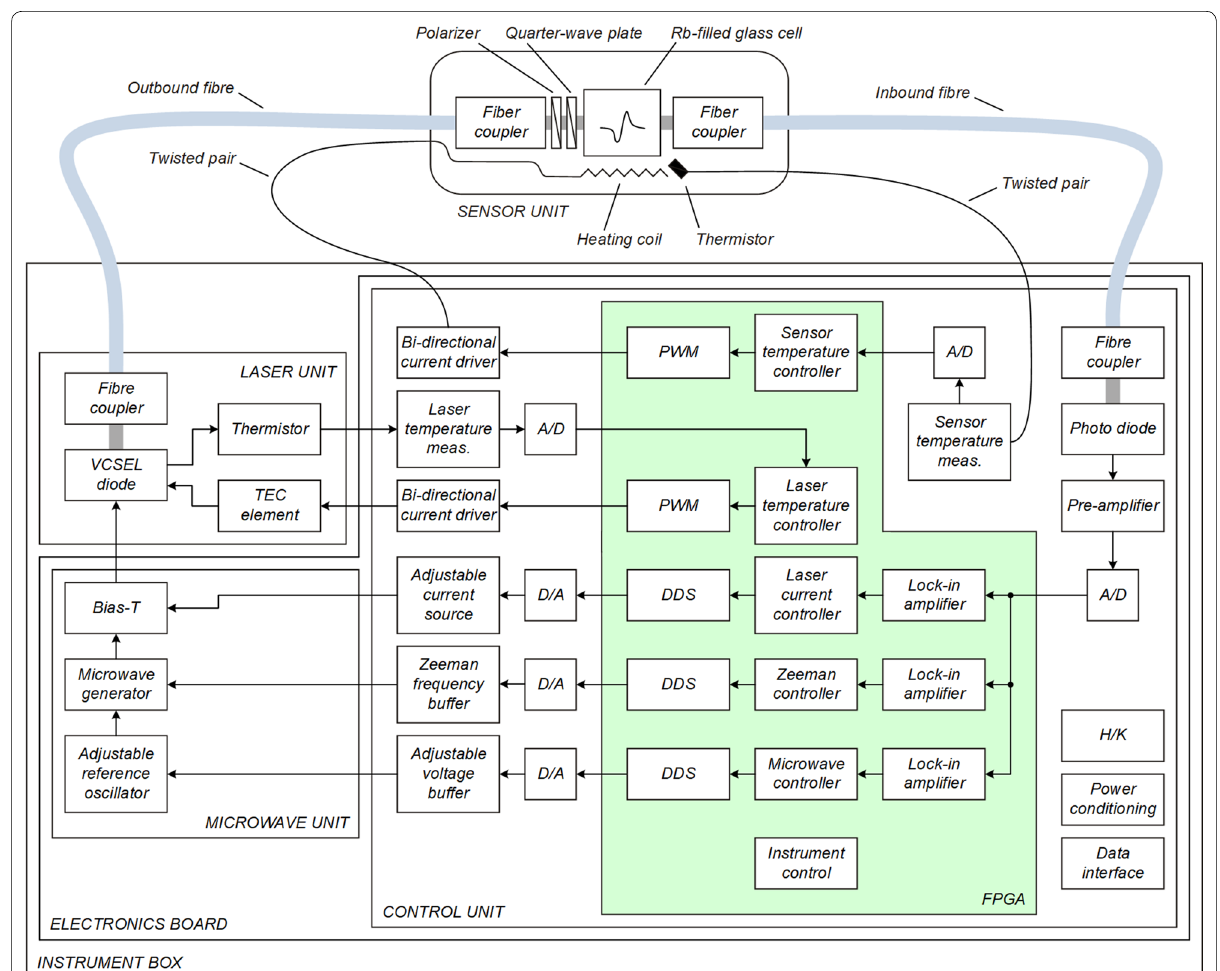
Fig. 5 CDSM block diagram. A/D analog-to-digital conversion, D/A digital-to-analog conversion, DDS direct digital synthesis, FPGA field programmable gate array, H/K housekeeping, PWM pulse-width-modulation, Rb rubidium, TEC thermo-electric-cooler, VCSEL vertical cavity surface emitting